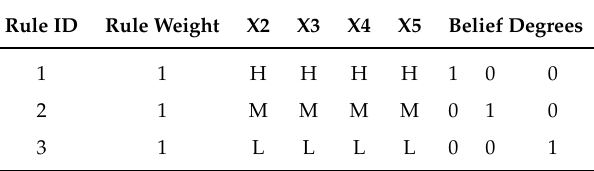
Figure 8. BRB framework for Power Usage Effectiveness ( PUE ). Table 3. Initial BRB for disjunctive